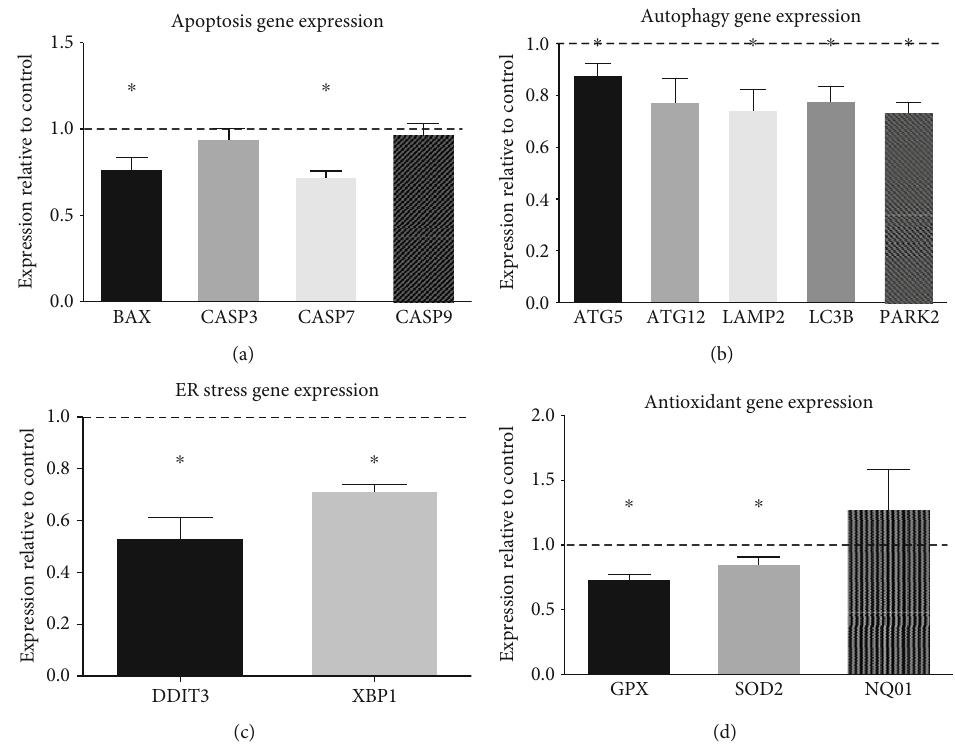
Figure 3: AMD cybrids cocultured with hRPCs show decreased expression levels of apoptosis, autophagy, ER stress, and antioxidant genes at 48hr. In order to examine the role of hRPCs in protecting AMD cybrids from mtDNA-mediated cellular damage, we used qRT-PCR analyses to measure the di ff erential gene expression pro fi les of apoptosis, autophagy, ER stress, and antioxidant genes in AMD cybrids with hRPCs versus AMD cybrids without hRPCs. (a – d) In AMD cybrids, hRPCs signi fi cantly downregulated apoptosis genes (a): BAX ( 77 : 5 % ± 6 : 3 % , p = 0 : 023 ), CASP3 ( 94 : 9 % ± 5 : 3 % , p = 0 : 400 ), CASP7 ( 72 : 8 % ± 3 : 0 % , p = 0 : 001 ), and CASP9 ( 97 : 4 % ± 6 : 0 % , p = 0 : 686 ); autophagy genes (b): ATG5 ( 88 : 3 % ± 3 : 9 % , p = 0 : 042 ), ATG12 ( 77 : 7 % ± 9 : 0 % , p = 0 : 068 ), LAMP2 ( 74 : 8 % ± 7 : 6 % , p = 0 : 029 ), LC3B ( 78 : 4 % ± 5 : 2 % , p = 0 : 014 ), and PARK2 ( 74 : 0 % ± 3 : 3 % , p = 0 : 001 ); ER stress genes (c): DDIT3 ( 53 : 8 % ± 7 : 4 % , p = 0 : 003 ), and XBP1 ( 71 : 9 % ± 2 : 0 % , p < 0 : 001 ); and antioxidant genes (d): GPX ( 74 : 3 % ± 3 : 1 % , p = 0 : 001 ), SOD2 ( 86 : 0 %% ± 4 : 9 % , p = 0 : 047 ), and NQO1 ( 128 : 6 % ± 3 : 0 % , p = 0 : 3894 ) compared to untreated AMD cybrids. Data are represented as mean ± S : E : M : , normalized to the control, which is normal cybrids assigned a value of 1 (dotted line). Data between the treatment and control groups were analyzed for di ff erences by performing one-sample t -tests on the expression fold change values from the fi ve cybrid lines for each gene ( n = 5 ), comparing the values with a hypothetical value of 1.